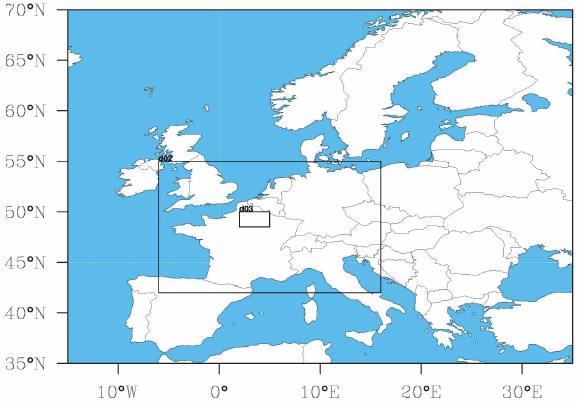
Fig. 1. Simulation domains: D01 over Western Europe, D02 Figure 1. Simulation domains: D01 over western Europe, D02 over France, Germany, Netherlands, Belgium, Switzerland, Luxembourg, Slovenia, most of Austia, and over France, Germany, Netherlands, Belgium, Switzerland, Luxem- part of U.K., Italy, Czech Republic, Spain, Croatia, and Poland, and D03 over the bourg, Slovenia, most of Austria, and parts of UK, Italy, Czech Re- greater Paris region in France. public, Spain, Croatia, and Poland, and D03 over the greater Paris region in France.